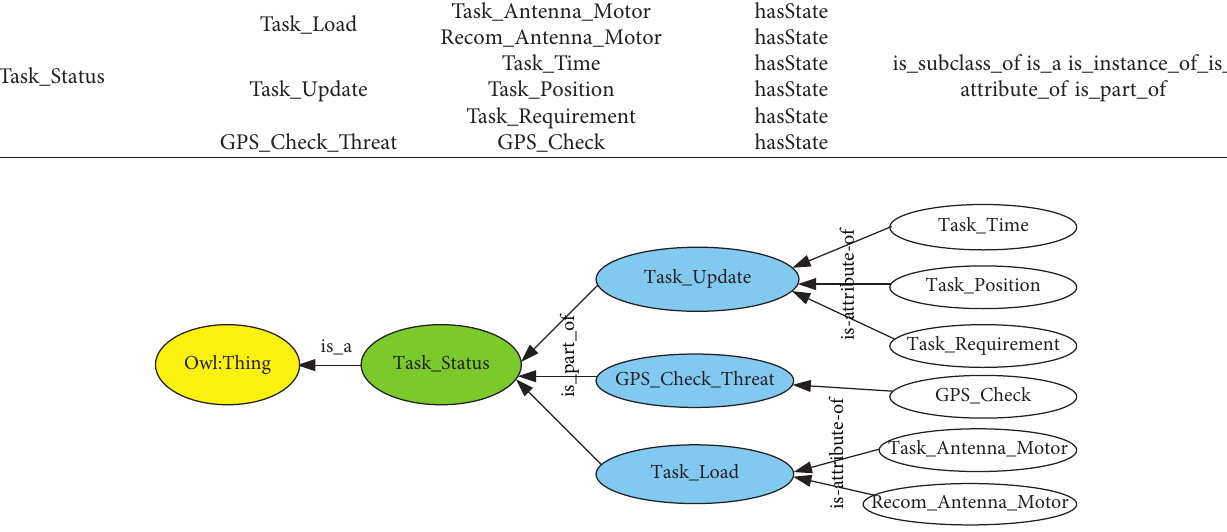
Figure 4: Structure of the task status application ontology.